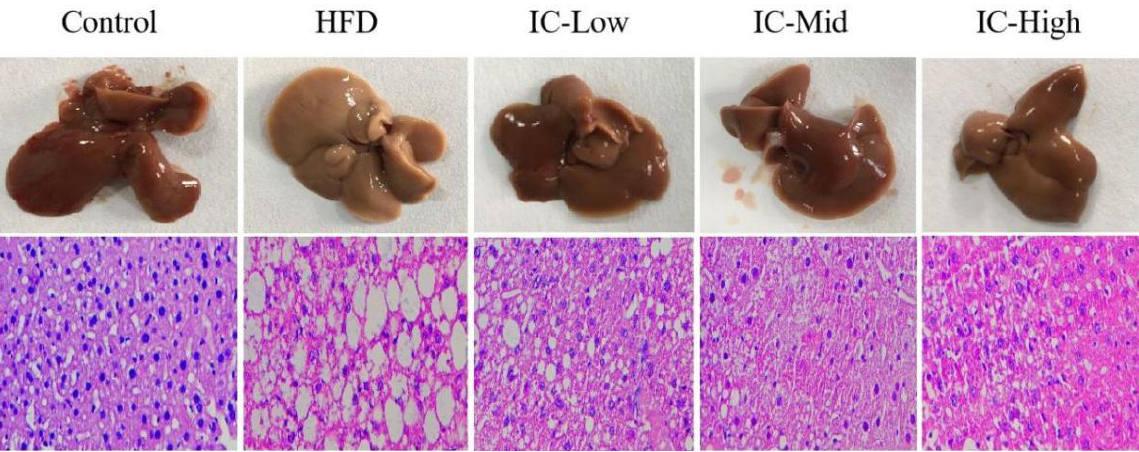
Figure 2. Histopathological changes in liver tissues from the five experimental mouse groups.